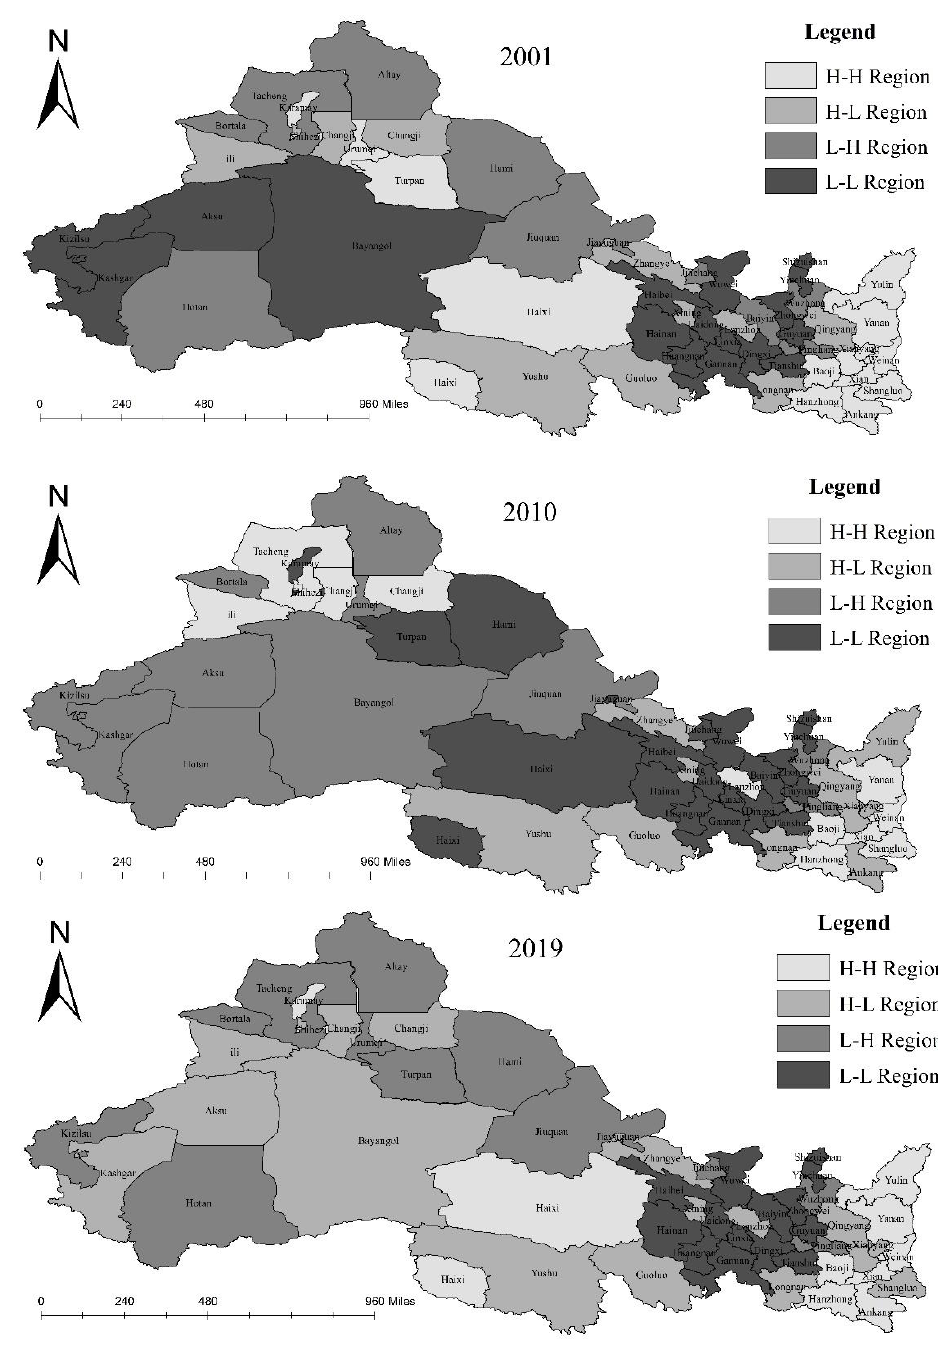
Figure 3. The LISA of urban and rural water shortage risks in Northwest China.